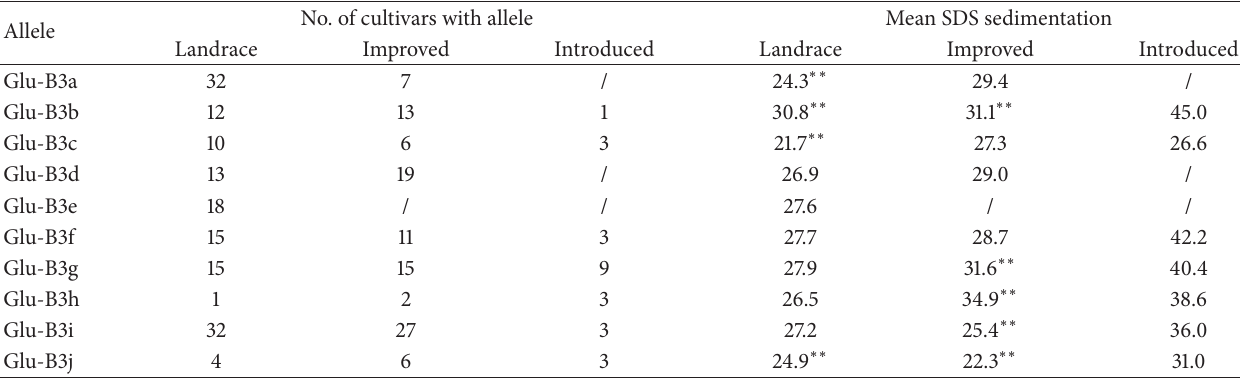
Table 2: Comparison of SDS-sedimentation volumes within Glu-B3 alleles from different kinds of cultivars.